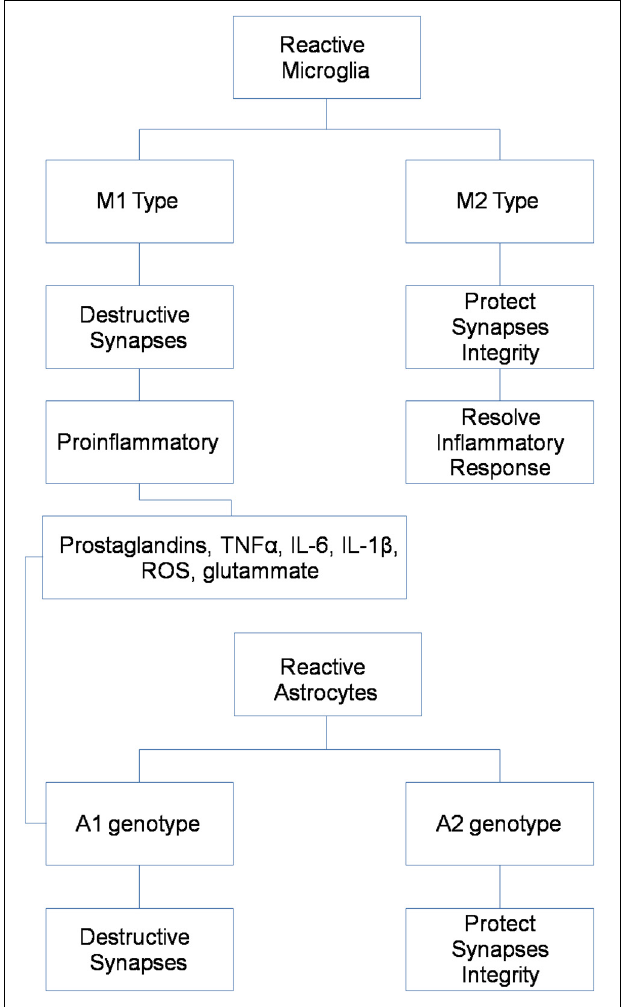
FIGURE 1 | Microglial and astrocytic phenotypes as possible targets for in vivo PET/MR imaging.